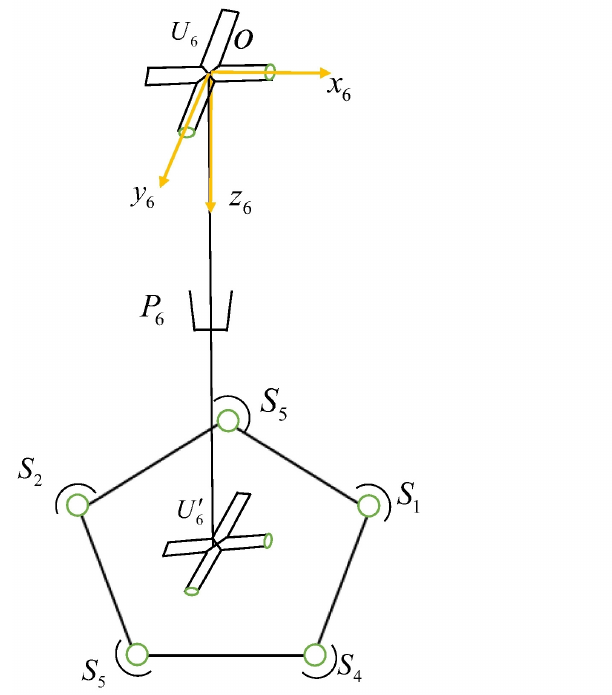
Figure 3. Sketch of limb